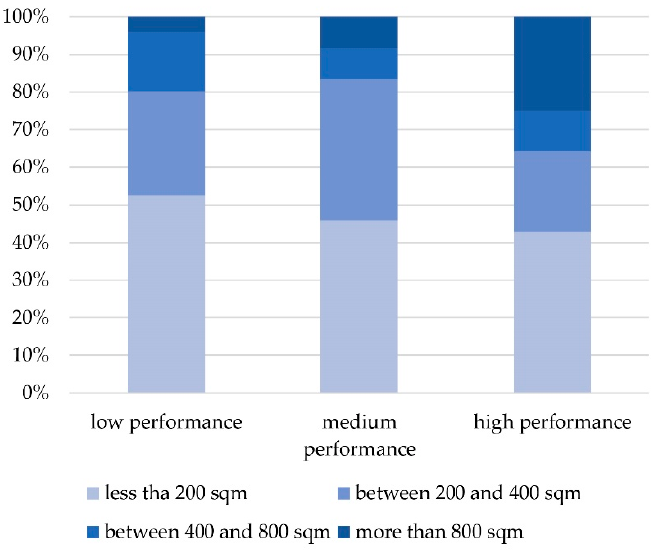
Figure 4. Dimension of CSs by performance category.